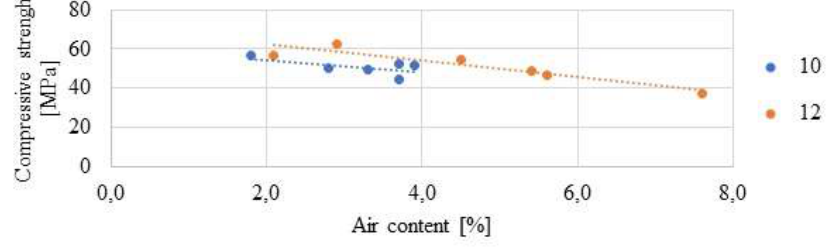
Figure 7. Series no. 10, 12 - Dependence of air content on compressive strength.